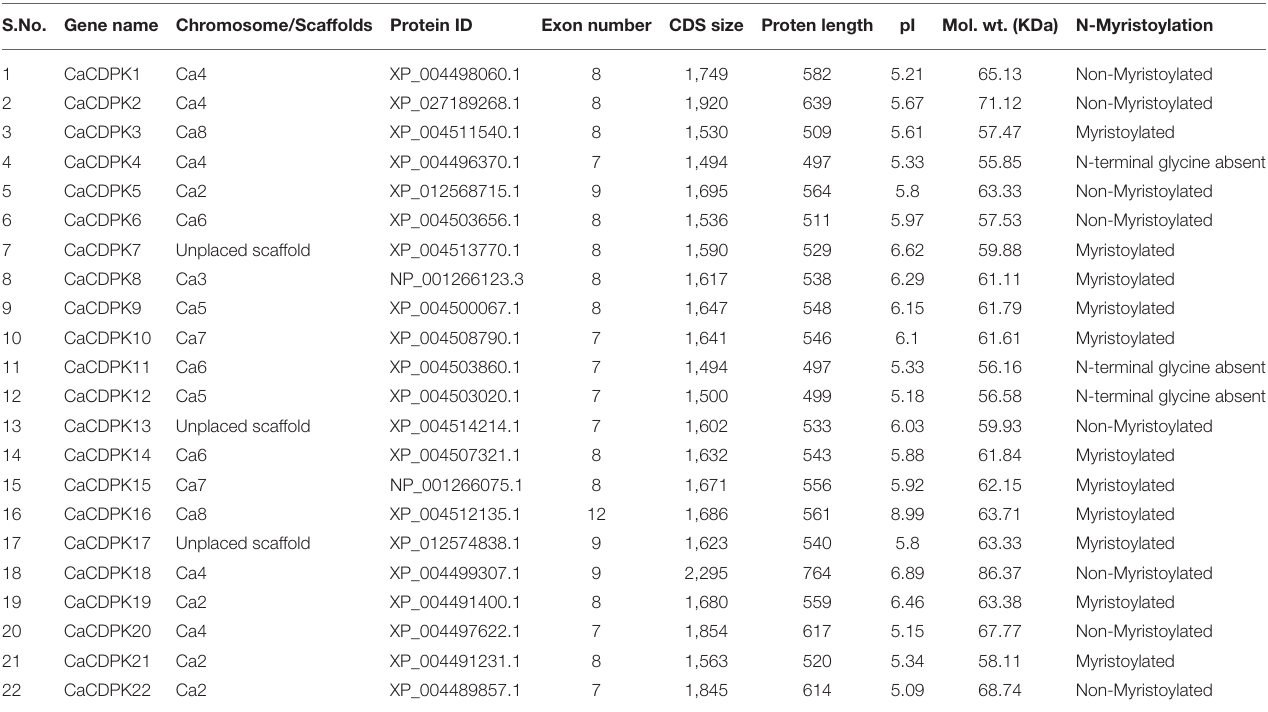
TABLE 1 | Summary of various features of the chickpea CDPK gene family. S.No. Gene name Chromosome/Scaffolds Protein